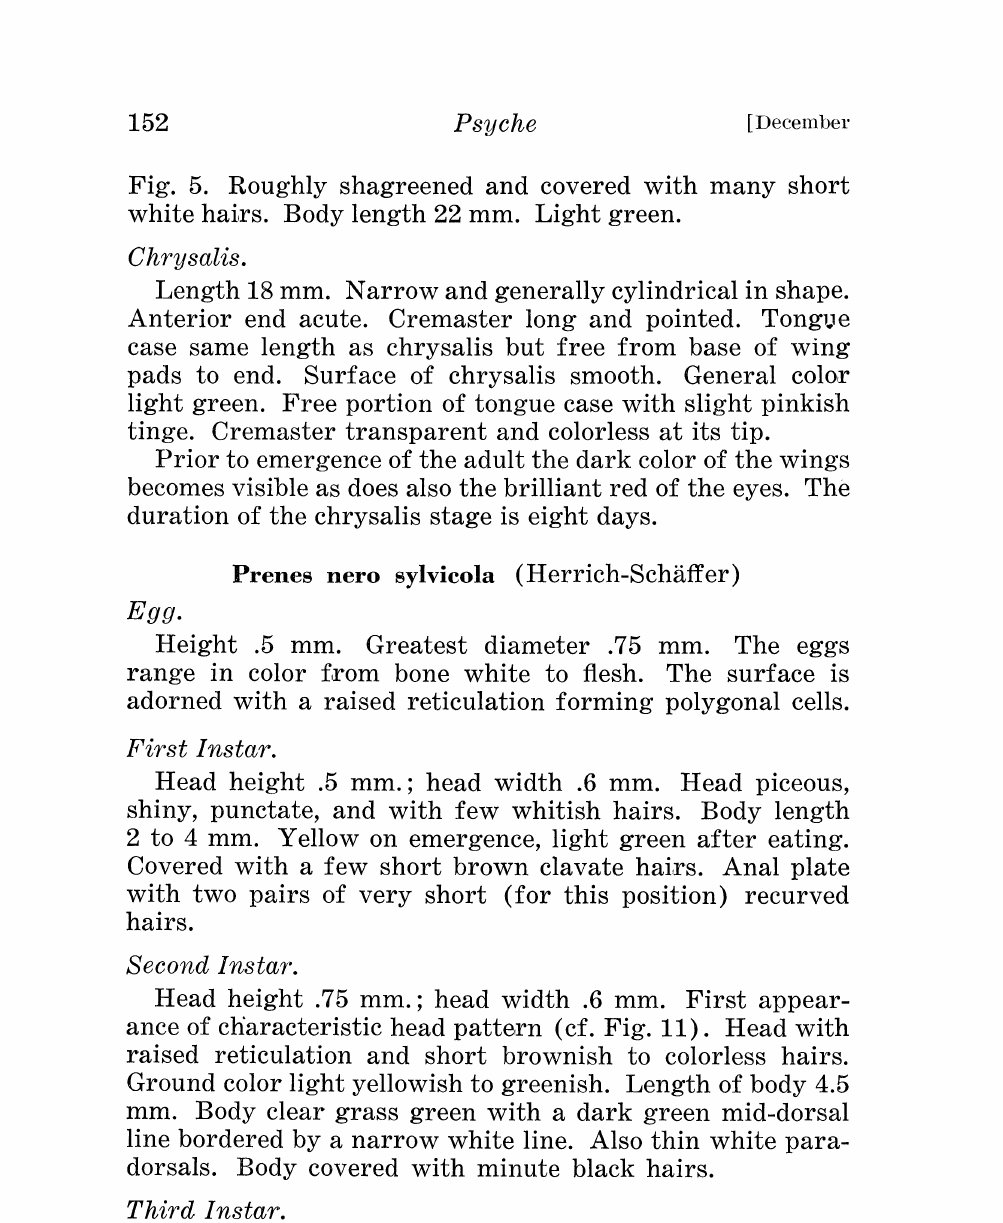
Fig. 5. Roughly shagreened and covered with many short white hai,rs. Body length 22 mm. Light